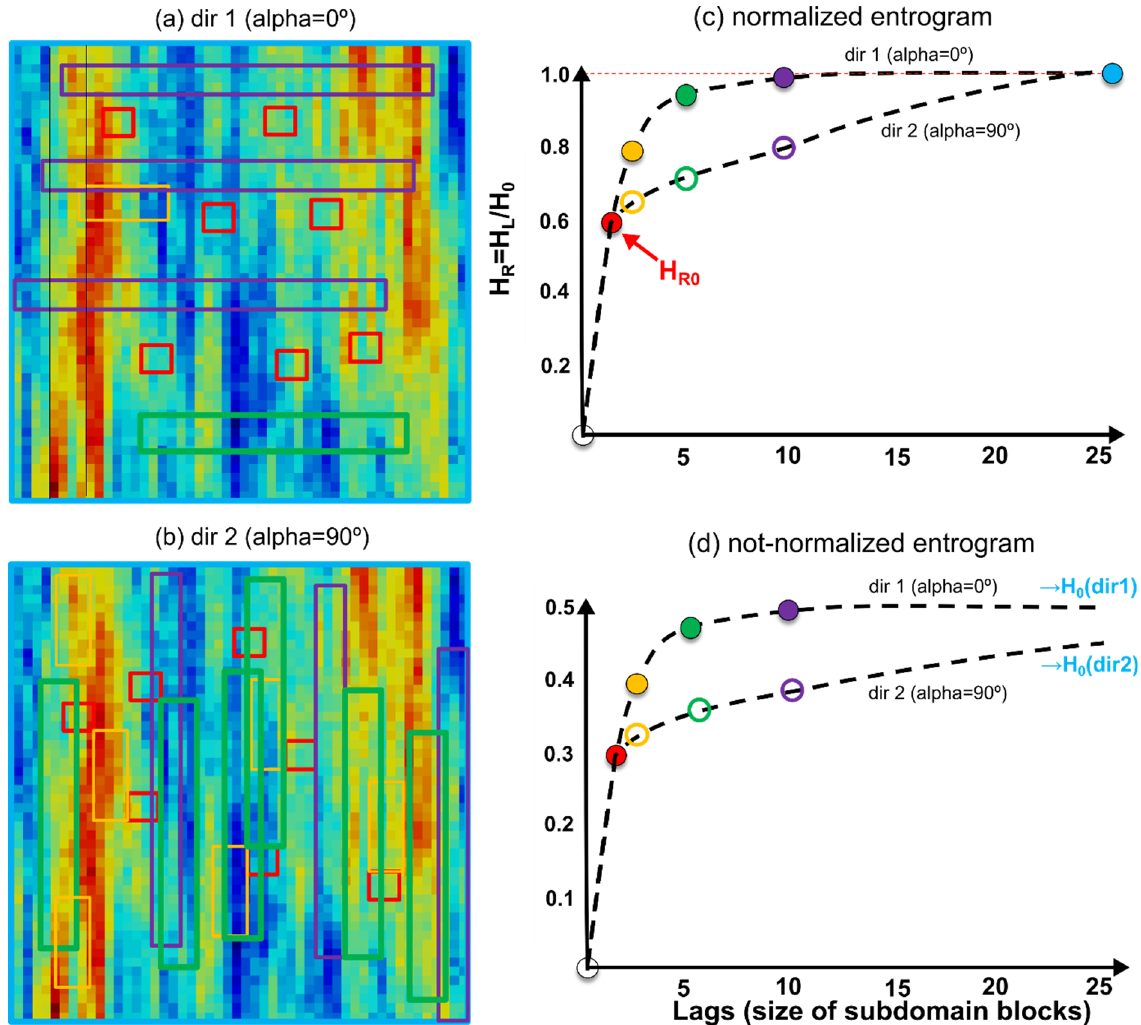
Figure 1. Conceptual example of the algorithm used by GEOENT to compute the directional en- trograms: ( a ) searching boxes are parallel to the horizontal axis (direction 1, α = 0 ◦ ); ( b ) searching boxes are parallel to the vertical axis (direction 2, α = 90 ◦ ); ( c ) normalised directional entrograms; ( d ) non ‐ normalised directional entrograms.